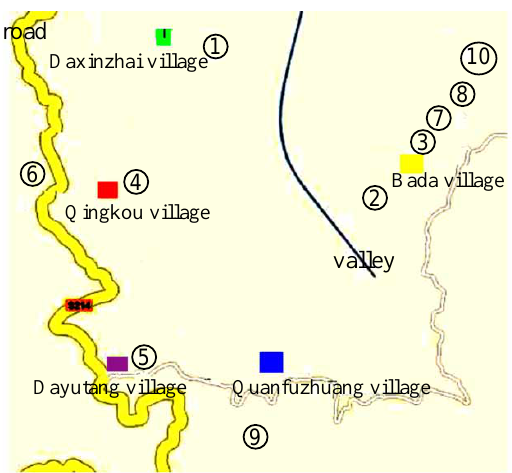
Fig. 1. The map of sampling sites